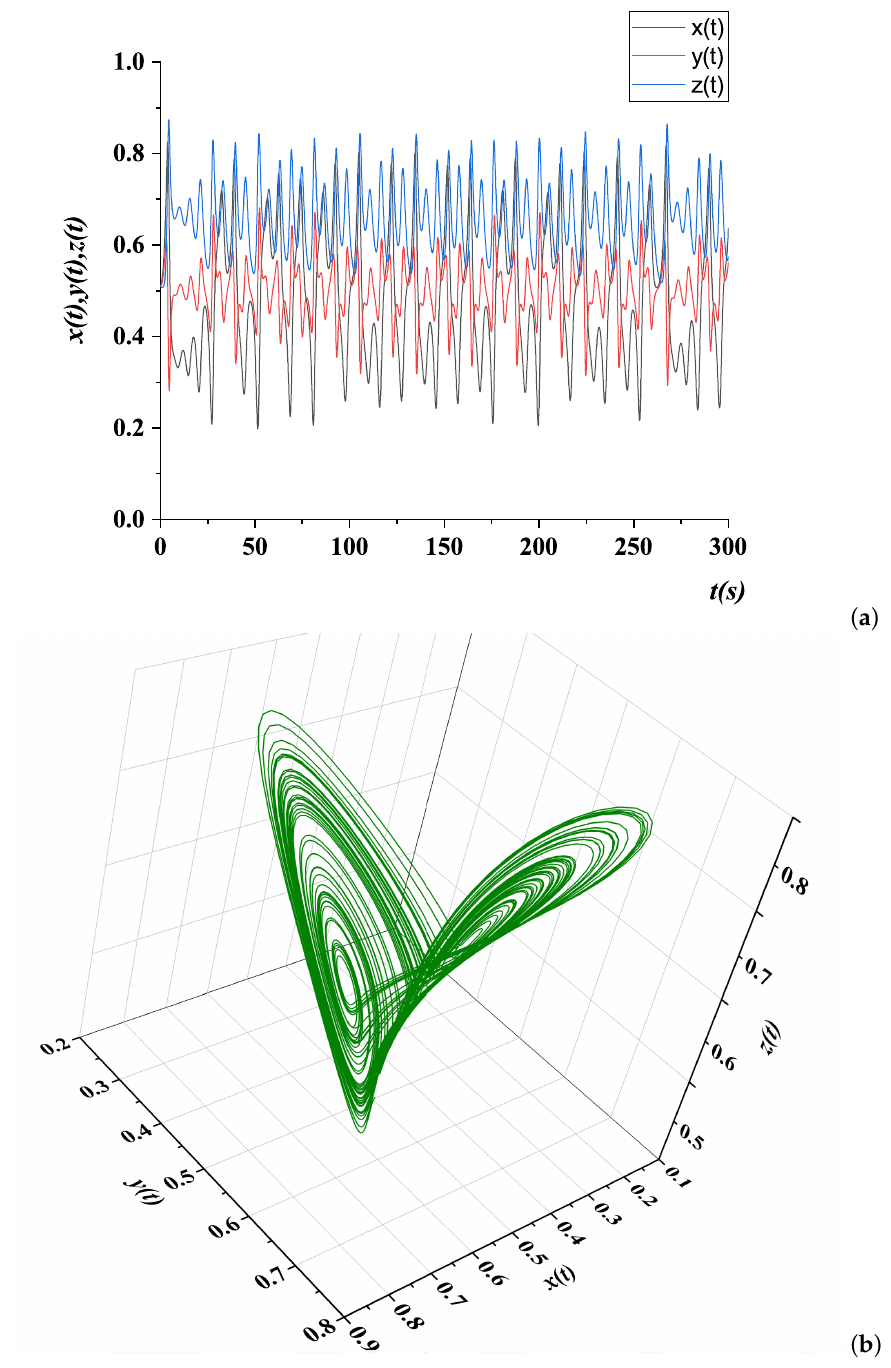
Figure 8. For the normalized Shimizu-Morioka system, beginning from initial conditions ( x , y , z ) = (0.51,0.51,0.51), ( a ) the nonlinear time series of the normalized Shimizu-Morioka system and ( b ) the corresponding attractor in a 3D phase space, are